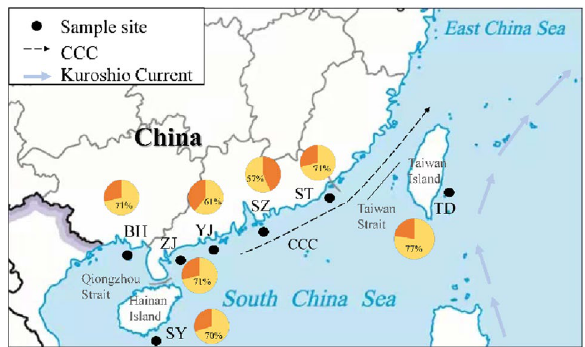
Figure 1. Map of the coast of mainland China illustrating the sampling locations of Trichiurus nanhaiensis . Each color in the pie charts represents the frequencies of the private (orange) and shared (yellow) haplotypes in each population. CCC China Coastal Current. The sampling site/population code is described in Table